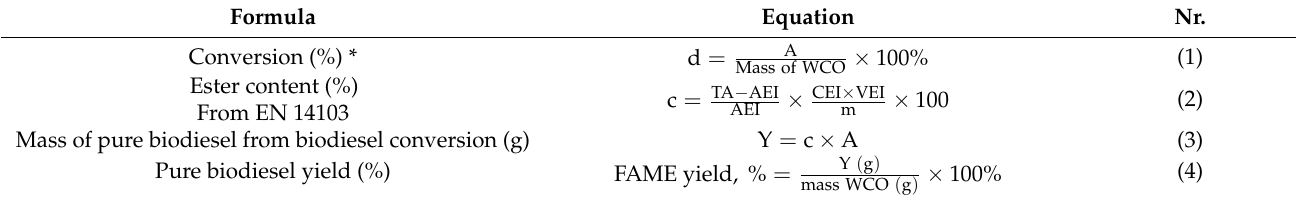
Table 5. Equations to calculate the biodiesel conversion, ester content, and biodiesel yield.